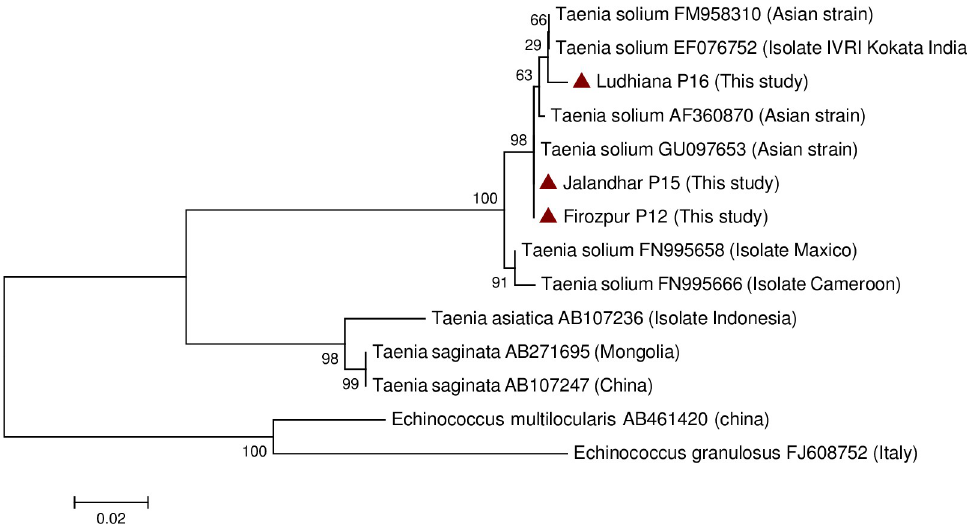
Fig 1. Phenogram construction of the cytochrome oxidase 1 gene of Taenia solium isolates from naturally infected pigs in Punjab (India) along with reference strains.